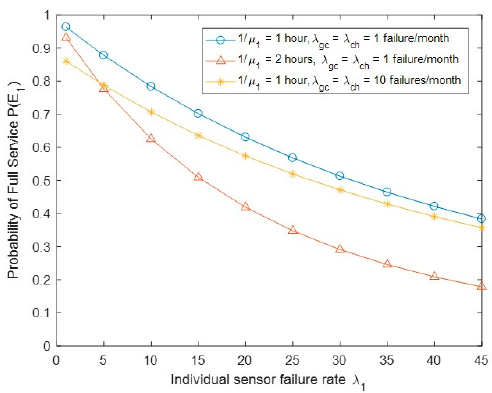
Figure 6. Probability of full service P ( E 1 ) vs. biosensor failure rate λ 1 .